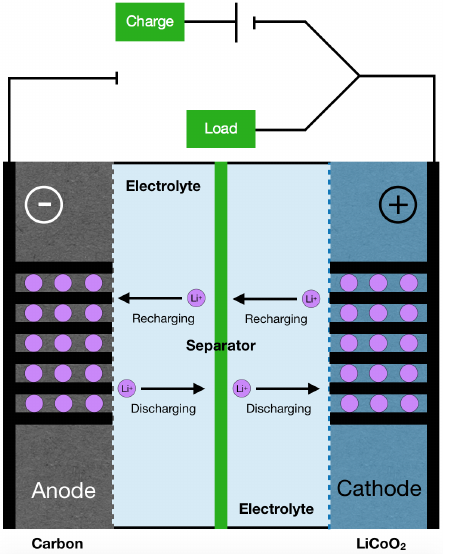
Figure 14. Schematic representation of the working principle of a generic lithium-ion